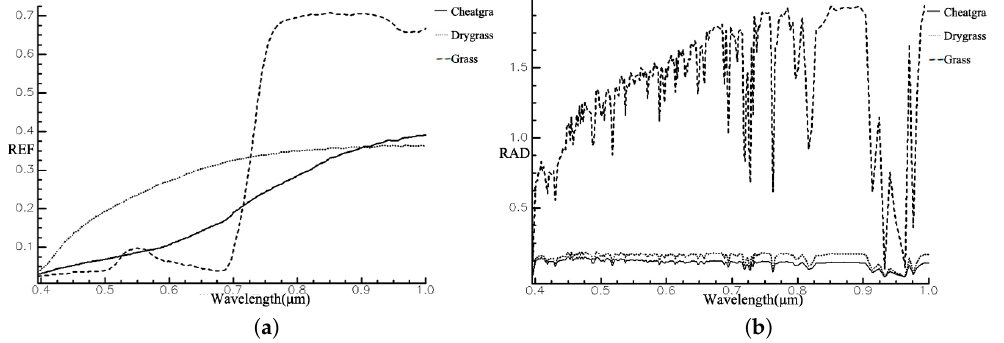
Figure 4. The standard spectral reflectance and simulated radiance of vegetation. ( a ) Reflectance; ( b )